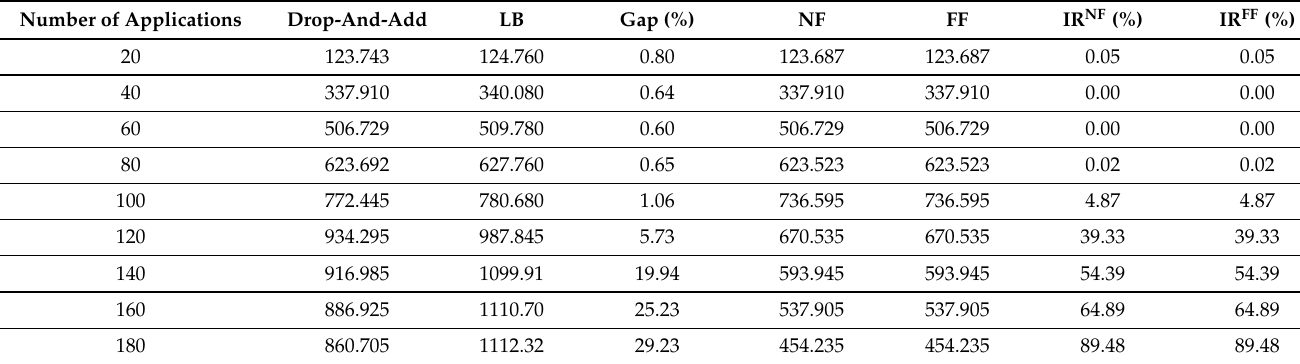
Figure 6. Objective value by the number of applications. Table 7. Comparison of solution qualities under different number of